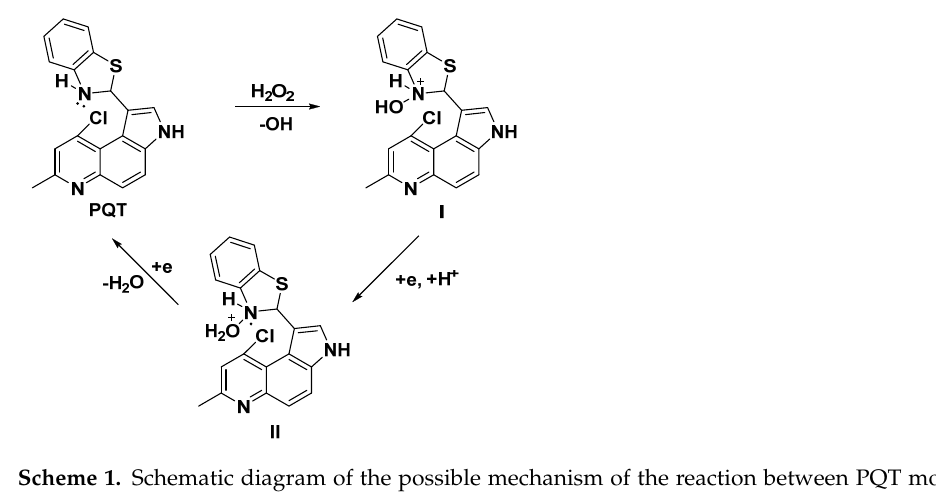
Scheme 1. Schematic diagram of the possible mechanism of the reaction between PQT molecule and H 2 O 2 .